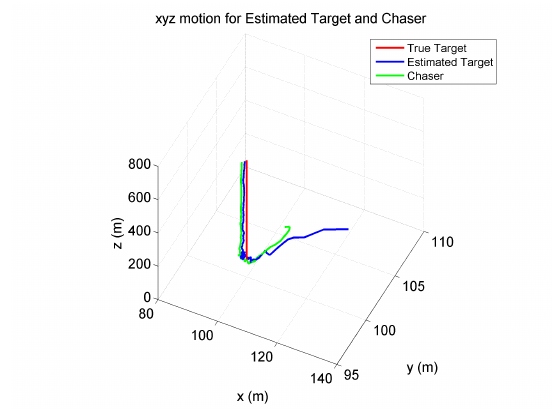
Figure 11. Chaser trajectory while tracking the estimated target (Case